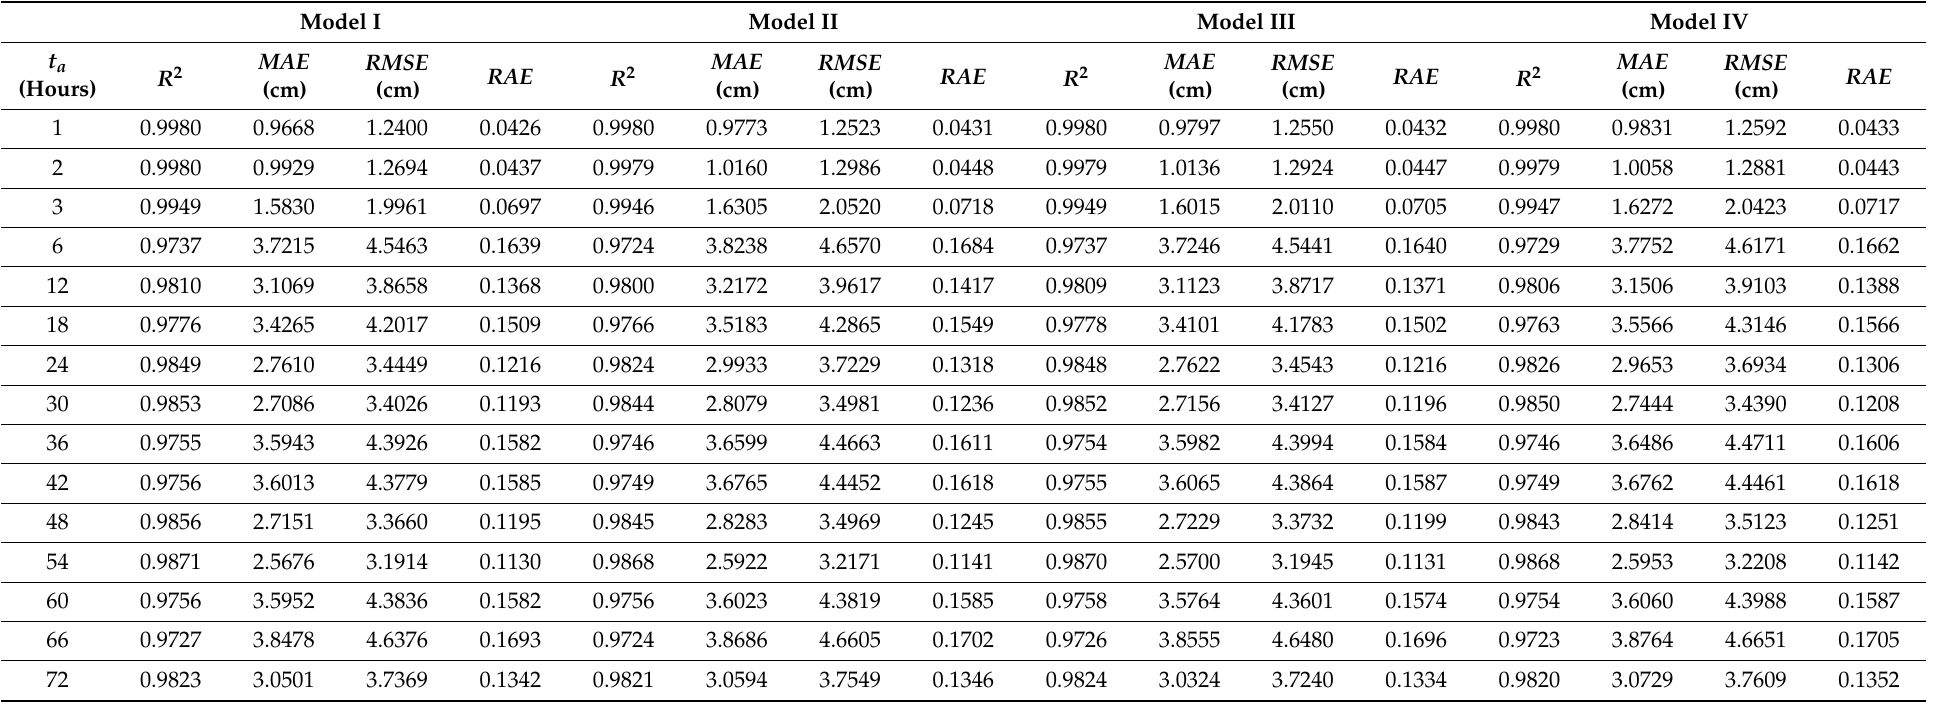
Table 2. Prediction performance in the training and testing of the NARX network for the four